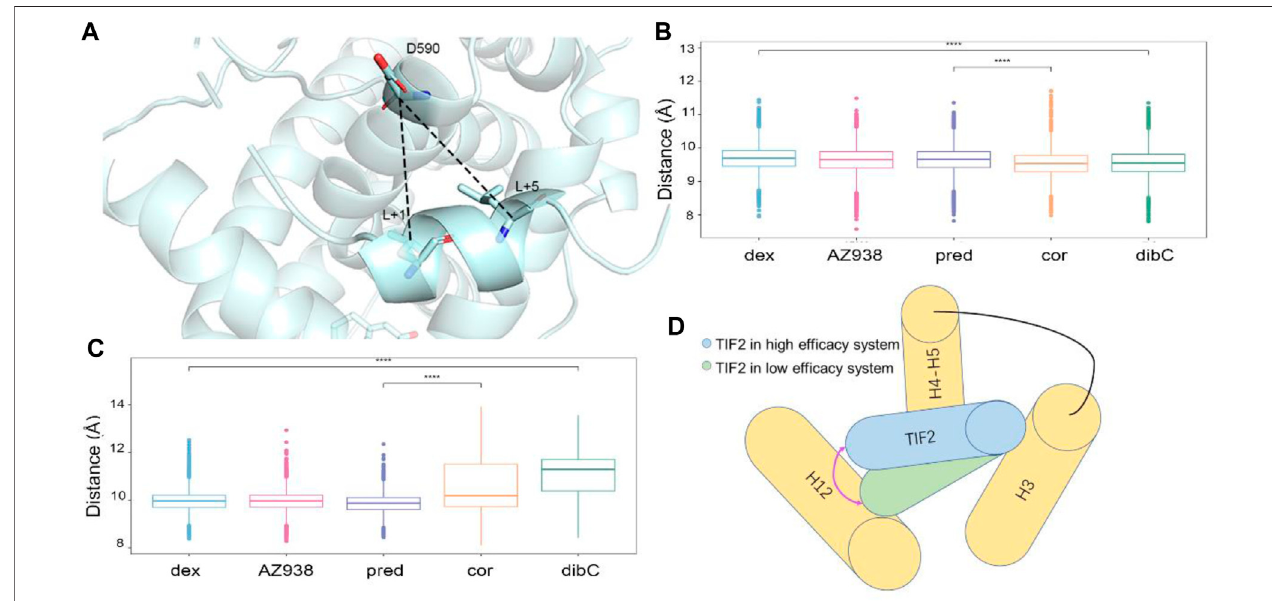
FIGURE 3 | Measurement of the direction of TIF2. (A) cartoon structure of the distance measured. Pivotal inter-residue distance re fl ecting the direction of TIF2 between (B) D590 and L+5 and (C) D590 and L+1. (D) model of TIF2-binding dynamics.